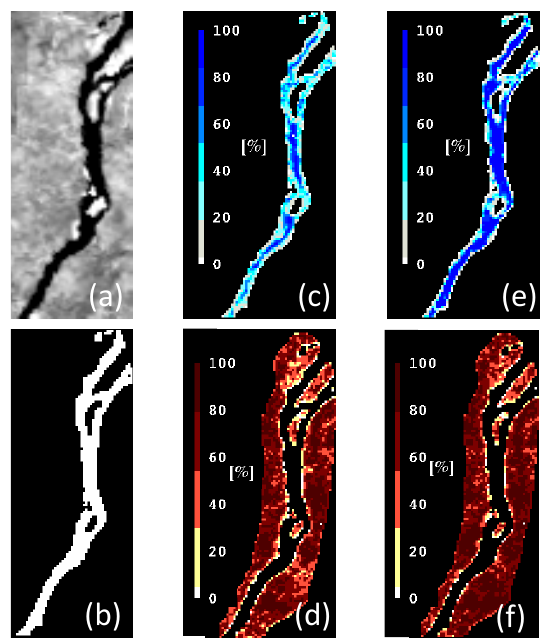
Figure 15. ( a ) Original image (date: 21 September 2000); ( b ) modified water mask from proposed method; ( c , d ) are maps of marginal probability of the water and land masks in the first iteration; ( e , f ) after the second iteration.